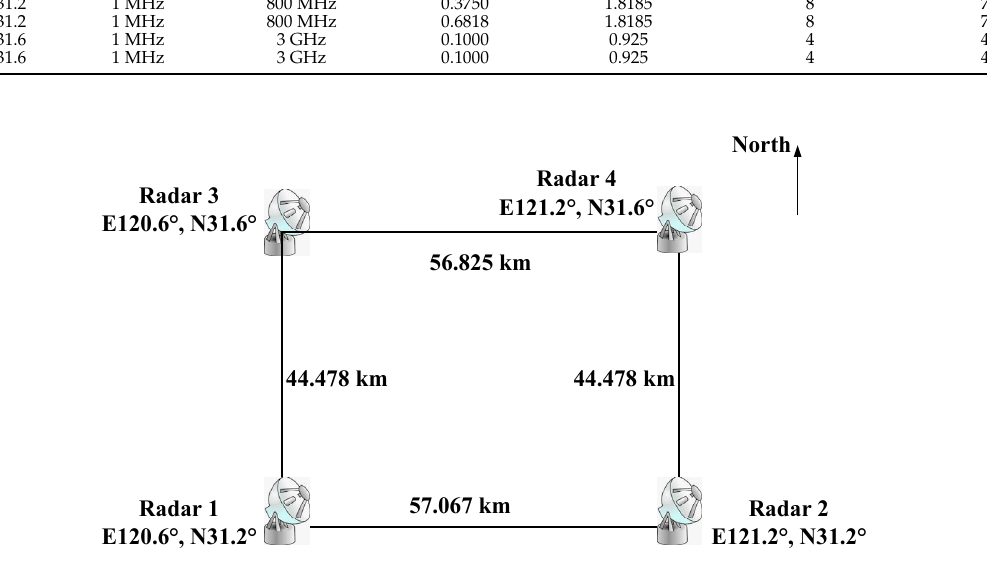
Figure 12. Distribution diagram of four radars. Table 7. Radar network parameters (four radars). Table 8. Jamming performance evaluation results of ground-based radar network (four